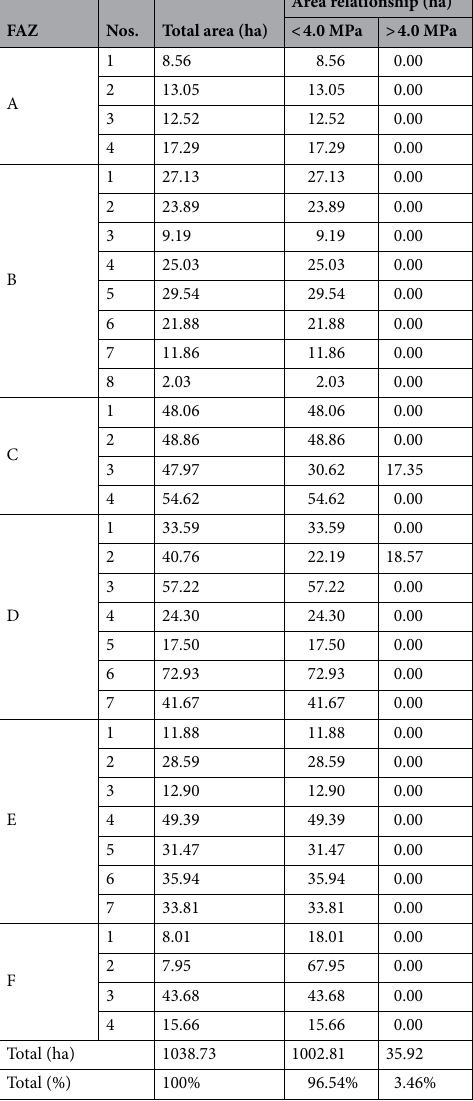
Table 1. Summary of assessed areas considering topographic